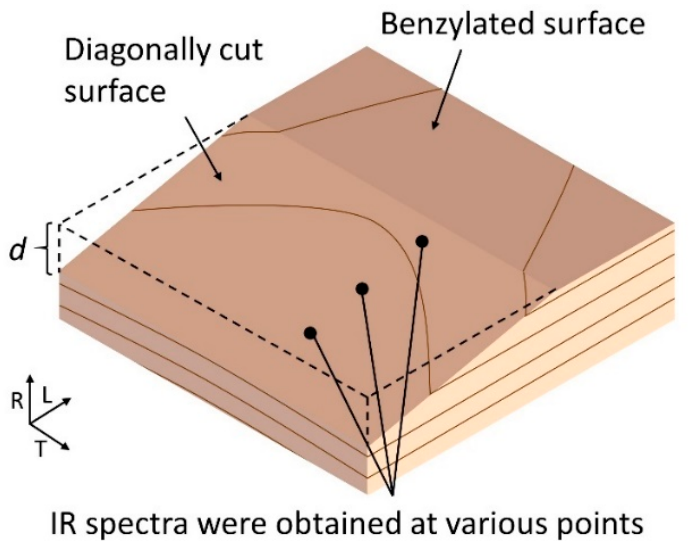
Figure 9. Schematic of cutting the wood diagonally and measuring the ATR at various points.